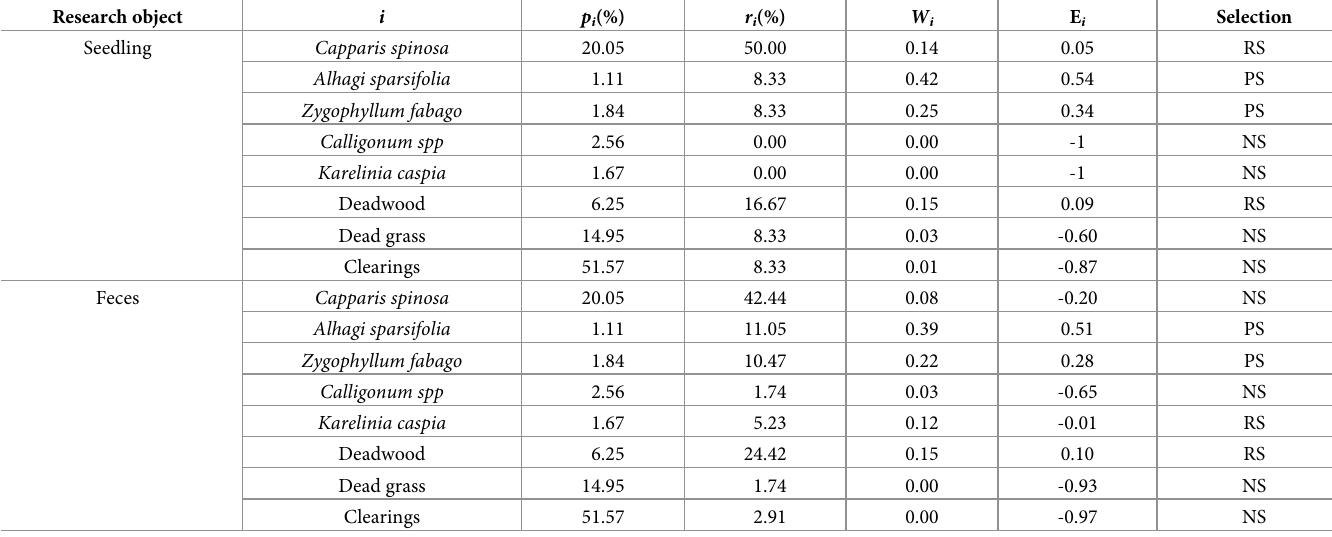
Table 1. Microhabitat selection of feces and